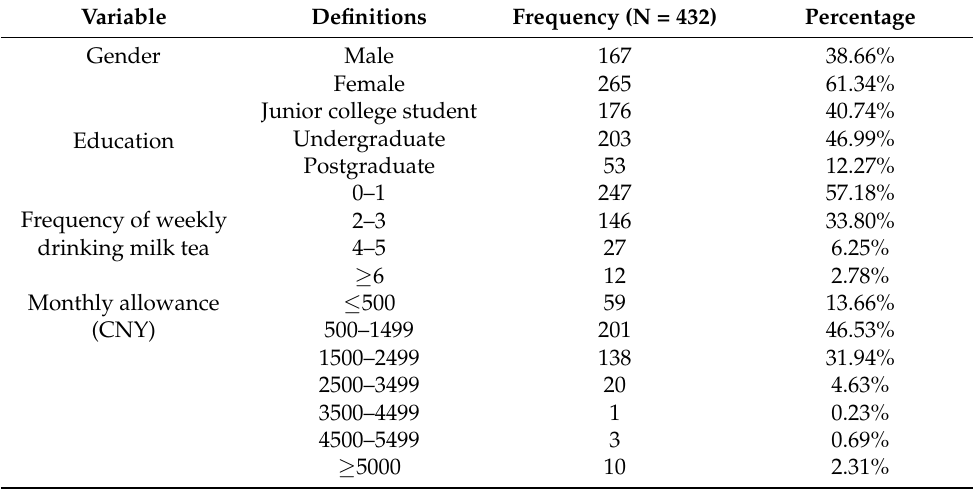
Table 2. Socio-demographic and economic characteristics of participants.